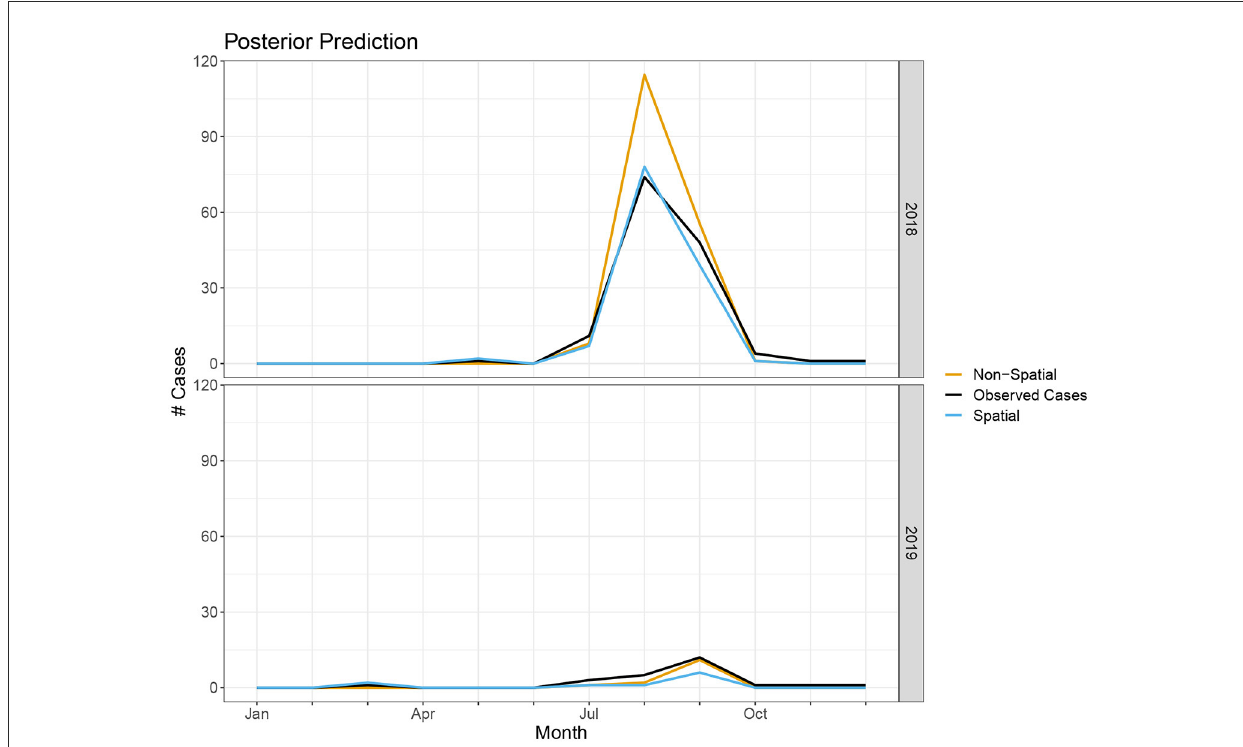
FIGURE5 Number of cases predicted in spatial and non-spatial model compared to true observed cases in 2018 and 2019.